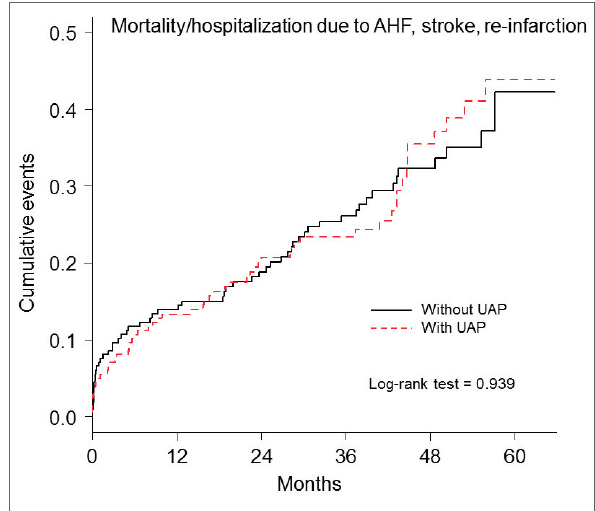
Fig. 1. The long-term survival and occurrence of cardio- vascular events. Kaplan-Meier’s curve of event-free survival (without death, re-infarction, hospitalization due to AHF and stroke) according to the presence of pre-infarction UAP (matched groups).